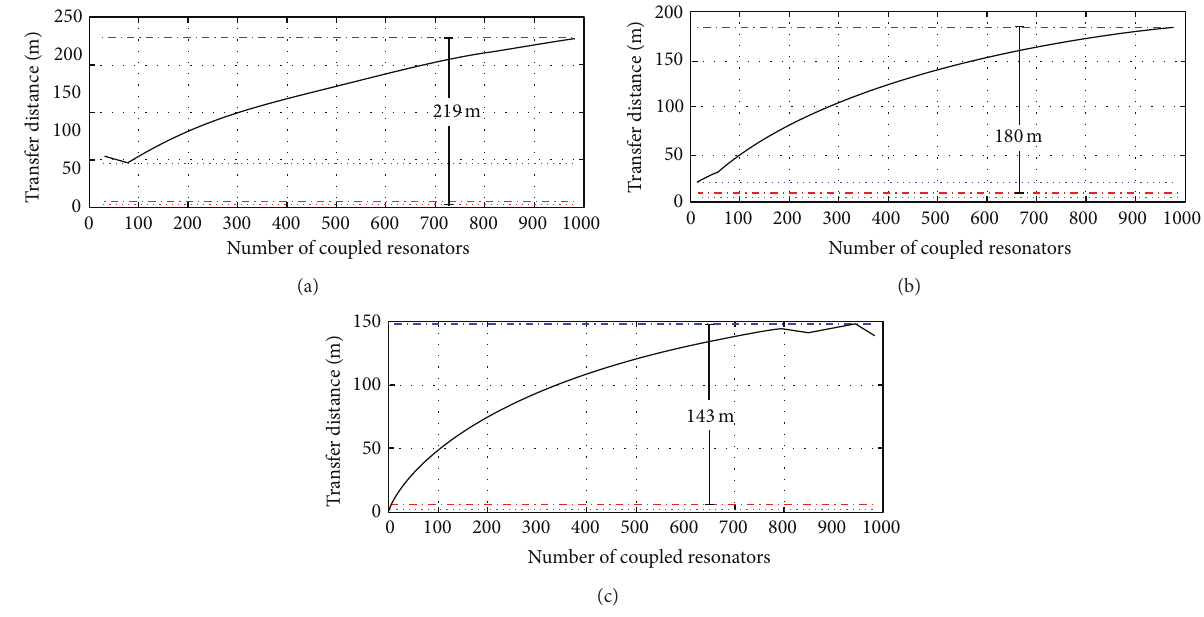
Figure 15: Same as Figure 13 but for HV/LV power